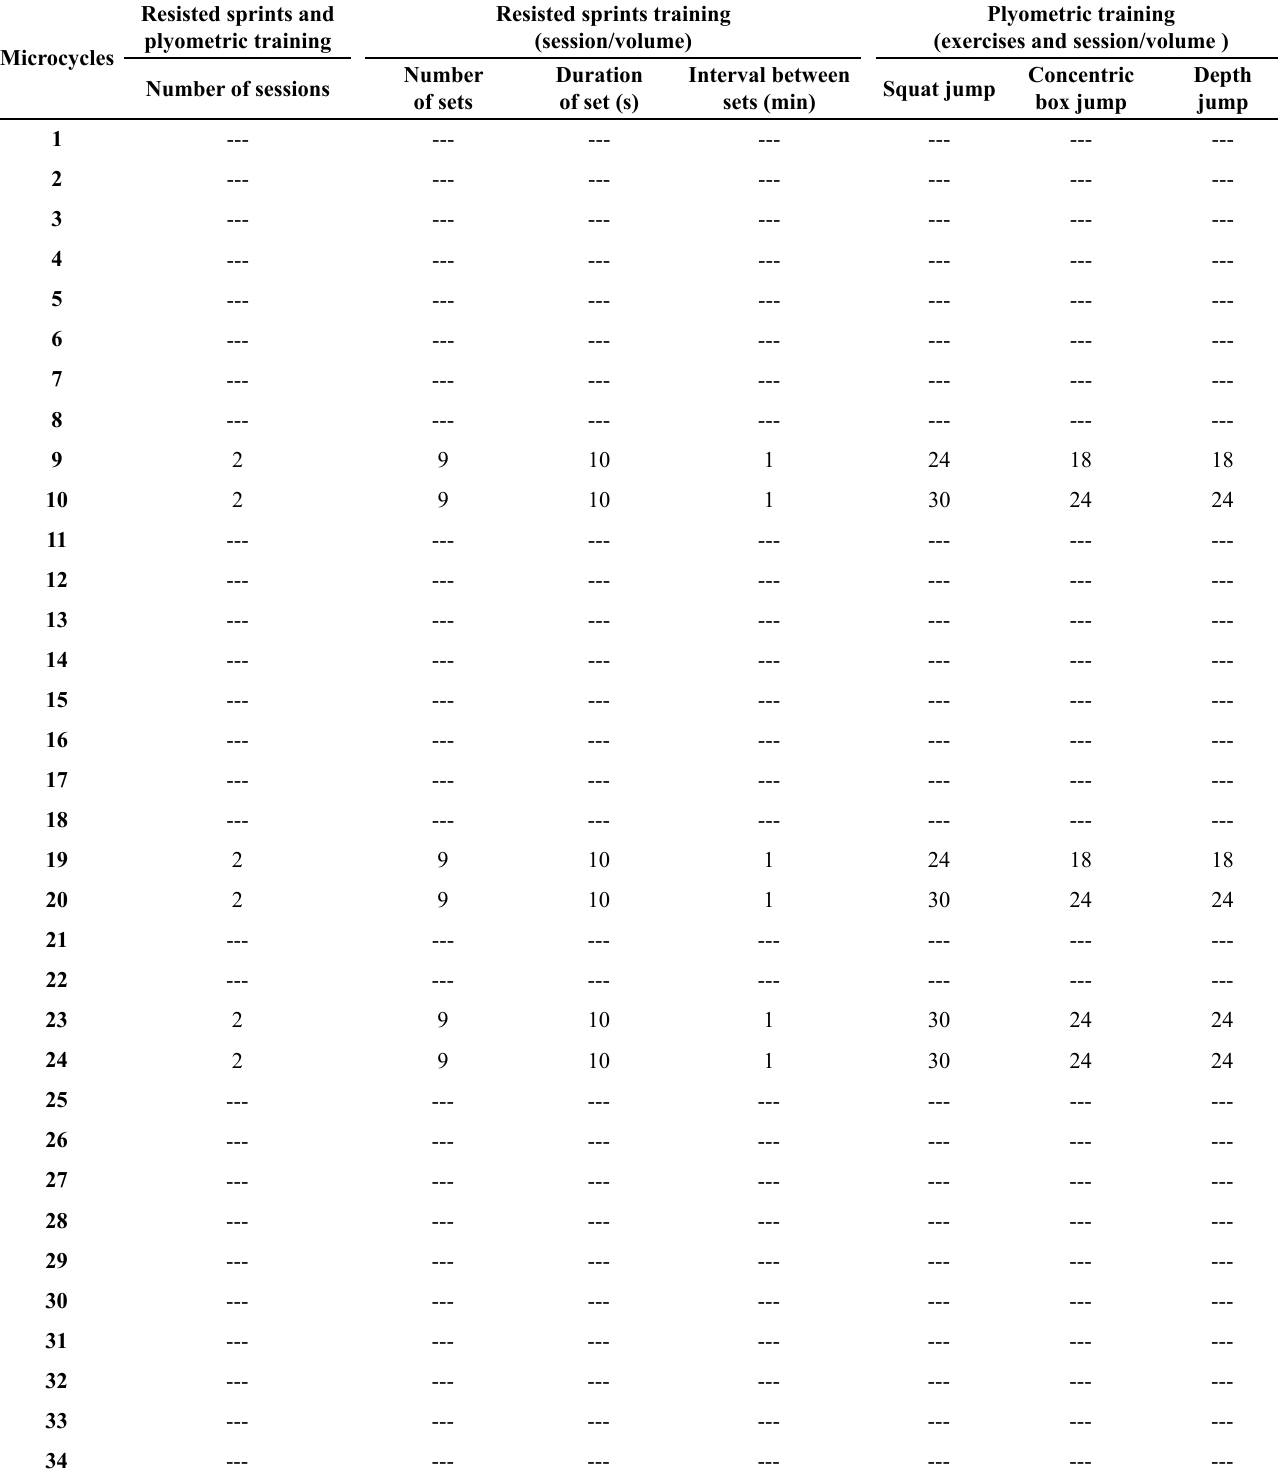
Table 3. Speed and Power training